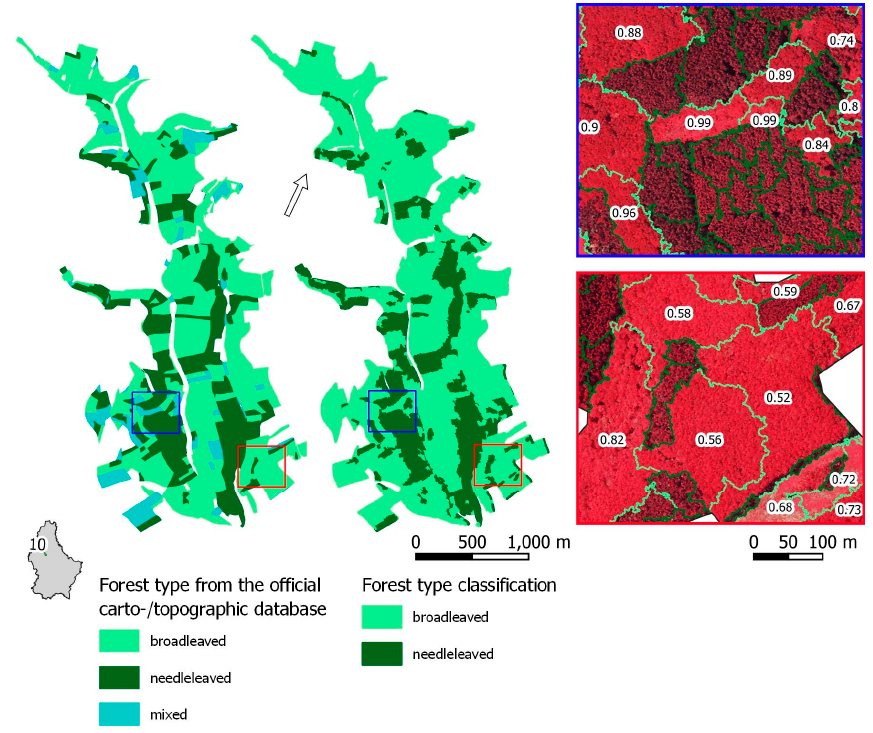
Figure 8. Area comparison of the best performing forest type classification (Segmentation: RGB+nIR; Training: Manual; Input Features: RGB+nIR+texture) with the official carto-/topographic database for each selected forest area.